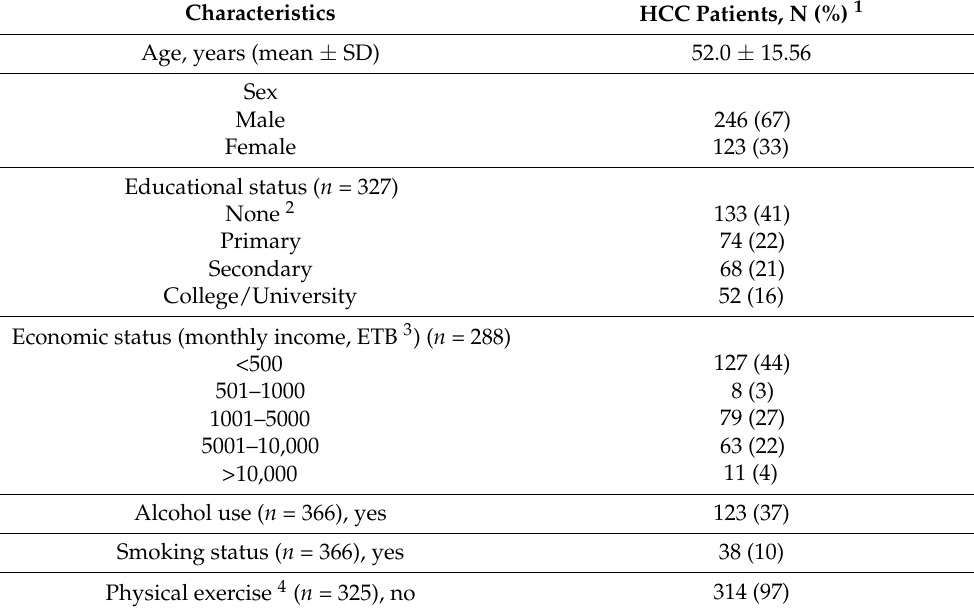
Table 1. Socio-demographic characteristics of HCC patients.